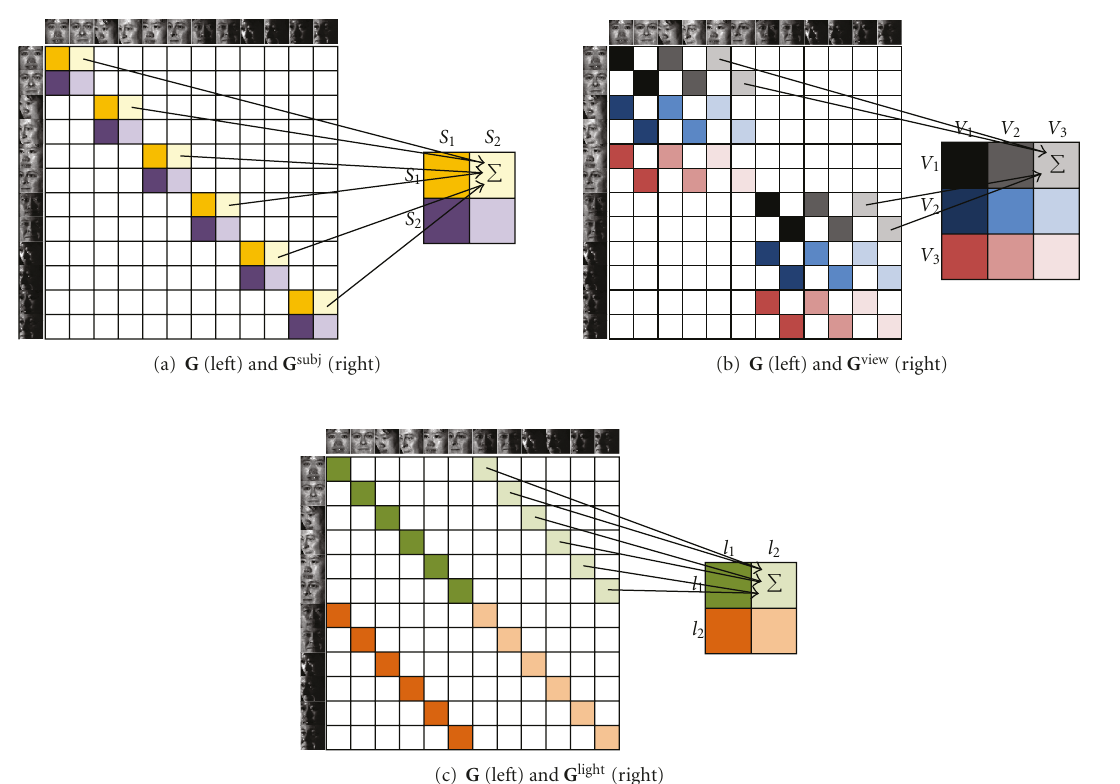
Figure 4: The relationships between the Gram matrix G defined in (4) and each of the Gram-like matrices G subj , G view , and G light defined in (8), where a training set has two subjects, three viewpoints, and two lighting conditions. Each of G subj , G view , and G light is calculated as the average of parts of the Gram matrix G . Each entry of these three Gram-like matrices is the average of same-color entries of G . (a) G subj consists of averages of dot products which represent the averages of the pairwise relationships between a group of subjects. (b) G view consists of averages of dot products which represent the averages of the pairwise relationships between di ff erent viewpoints. (c) G light consists of averages of dot products which represent the averages of the pairwise relationships between di ff erent lighting